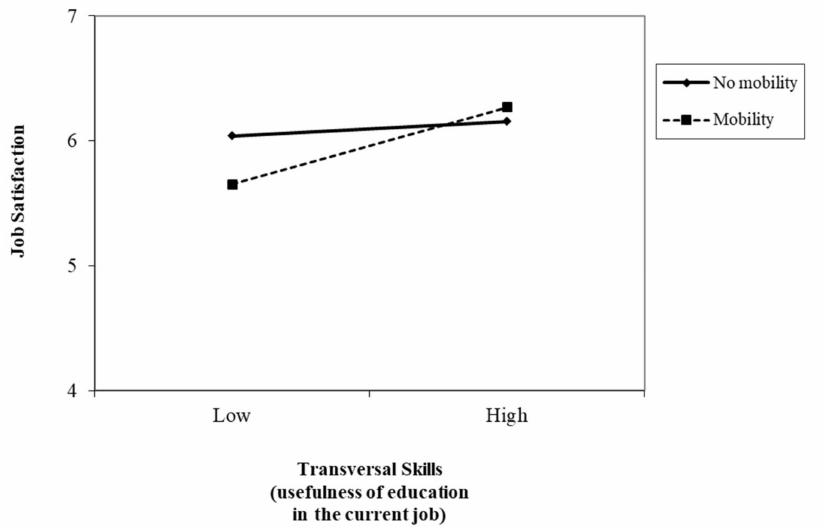
Figure 5. Interaction between transversal skills (usefulness of education in the current job) and mobility in predicting job